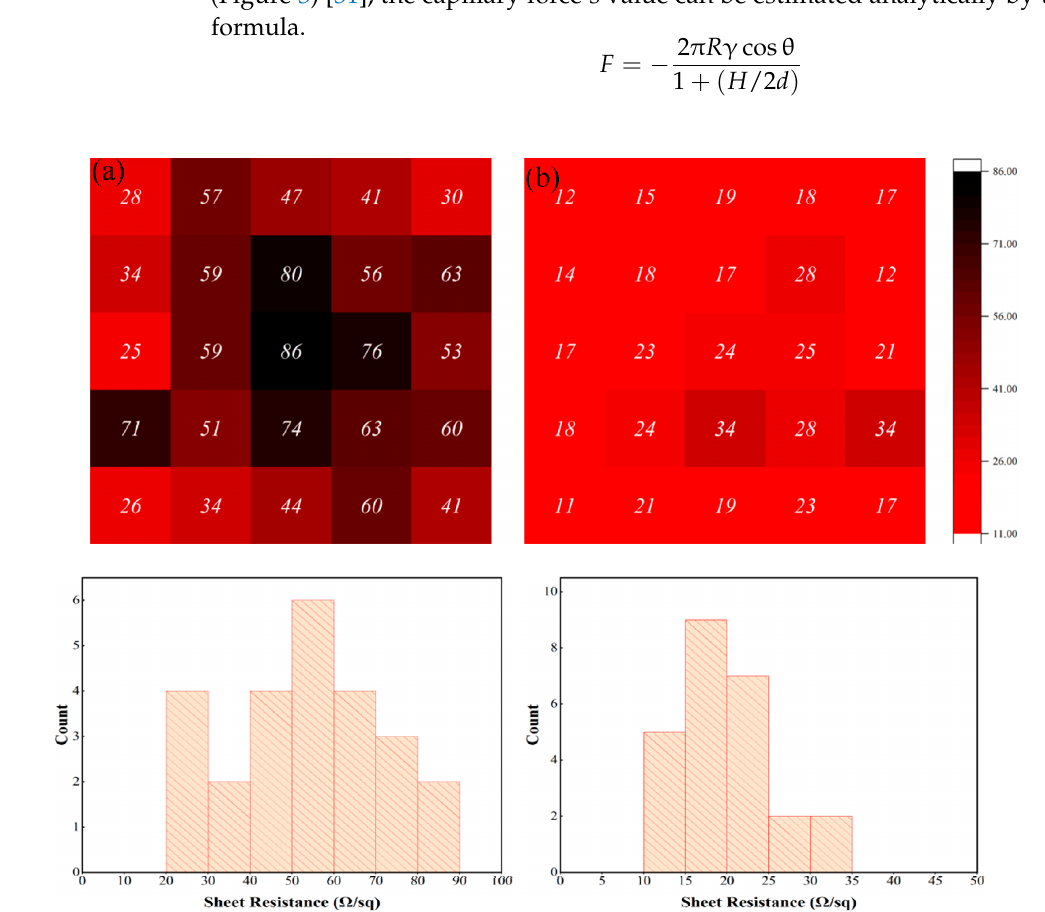
Figure 2. Sheet resistance distribution of silver nanowires before and after moisture treatment: ( a ) before moisture treatment of AgNWs-TCF, ( b ) after moisture treatment of AgNWs-TCF.